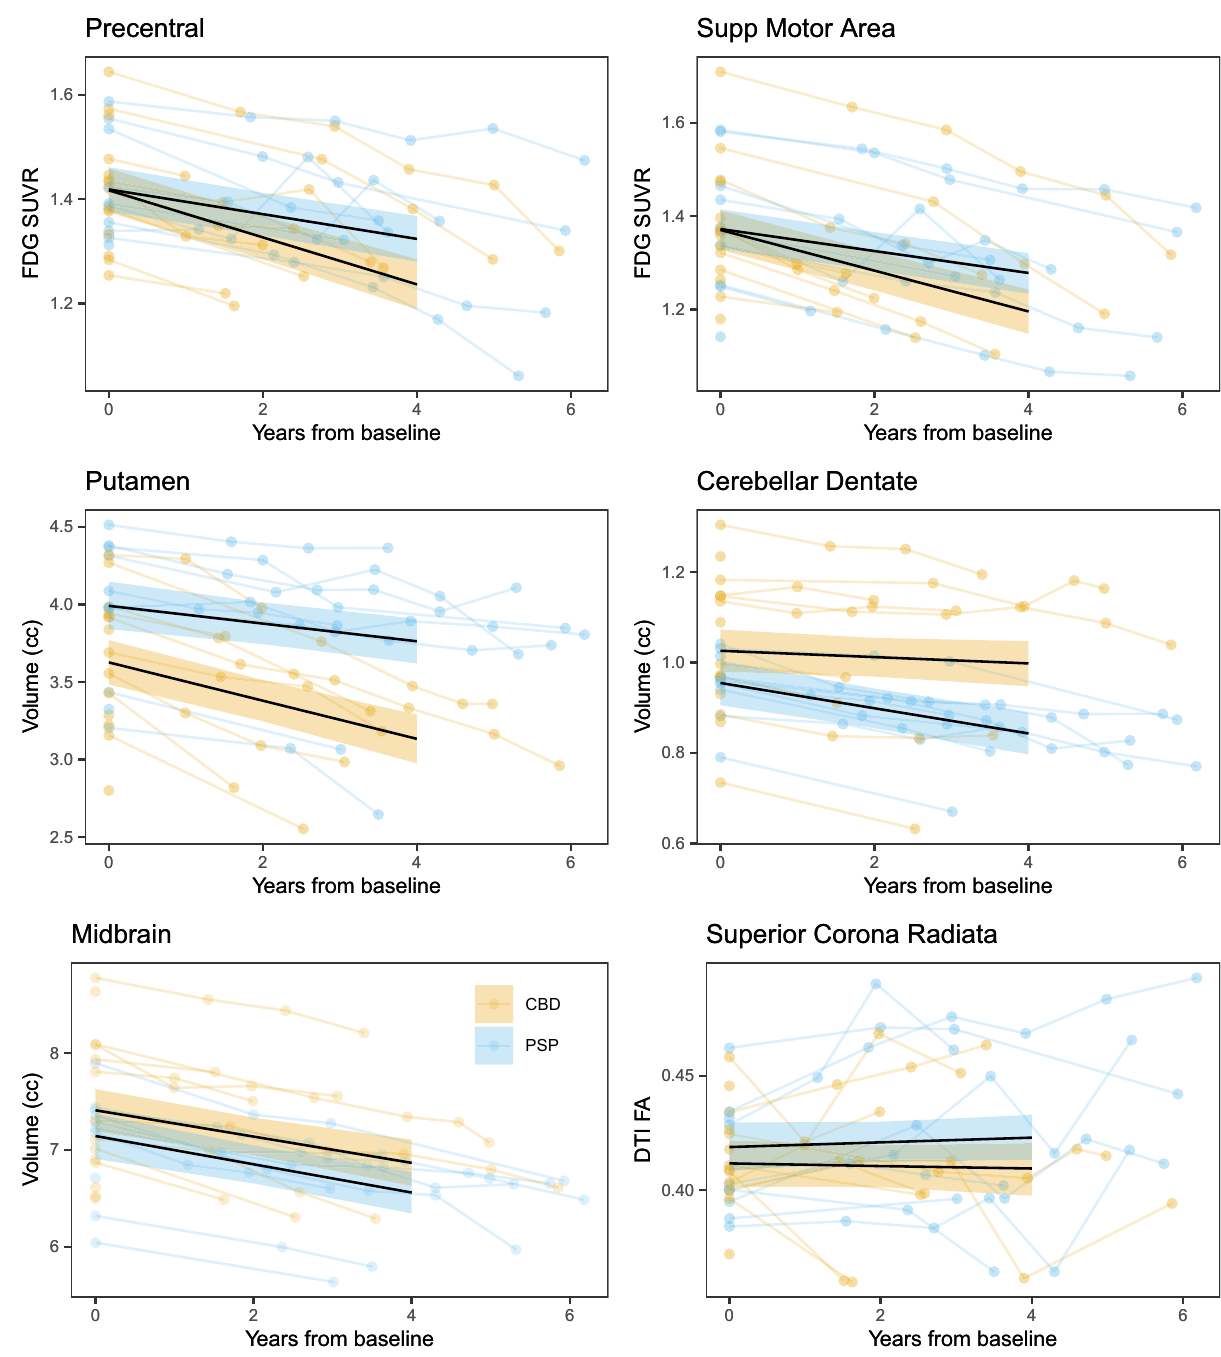
Fig. 5 Trajectories of decline in regional FDG-PET metabolism, MRI volume, and DTI-fractional anisotropy by pathology. Trajectories are shown for progressive apraxia of speech patients with corticobasal degeneration (CBD) or progressive supranuclear palsy (PSP) pathology. Median posterior fi ts of the Bayesian hierarchical models using baseline as the timescale anchor are shown as black lines, with 90% posterior intervals colored by pathological diagnosis for six selected regions, results averaged across hemispheres, across the three neuroimaging modalities. The data used to fi t the model are underlaid, again colored by diagnosis, and averaged across hemispheres, with scans from an individual connected by line segments. Fitted values extend to four years, the median time from baseline to death in the CBD group, and where we have a majority of our data across both diagnosis groups. Precentral cortex = motor cortex. Source data are provided as a Source Data fi